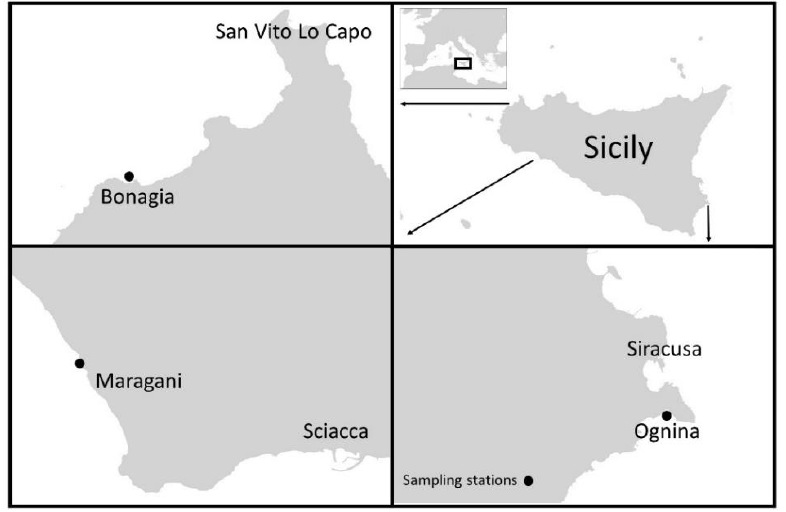
Figure 6. P. oceanica sampling locations along the coasts of